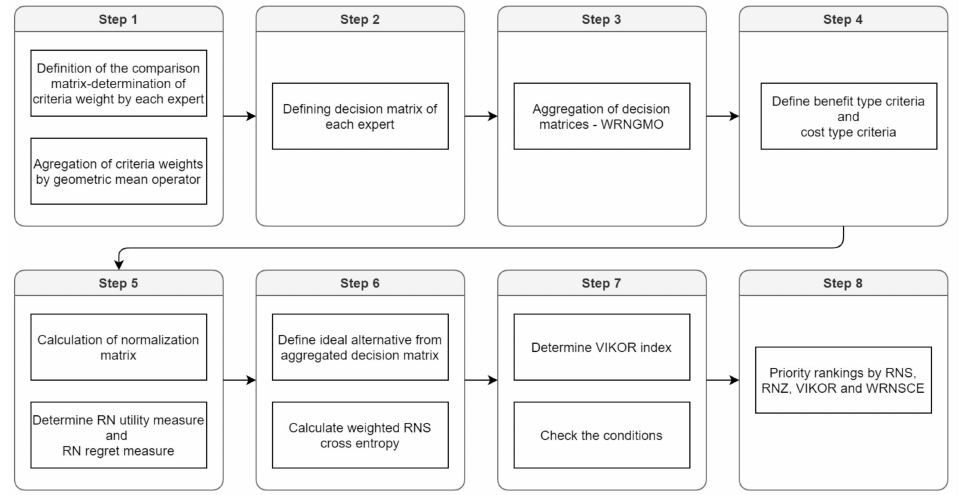
Figure 1. Framework of proposed